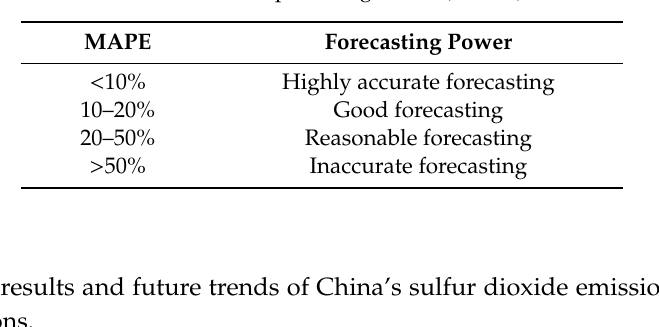
Table 3. Mean absolute percentage error (MAPE)